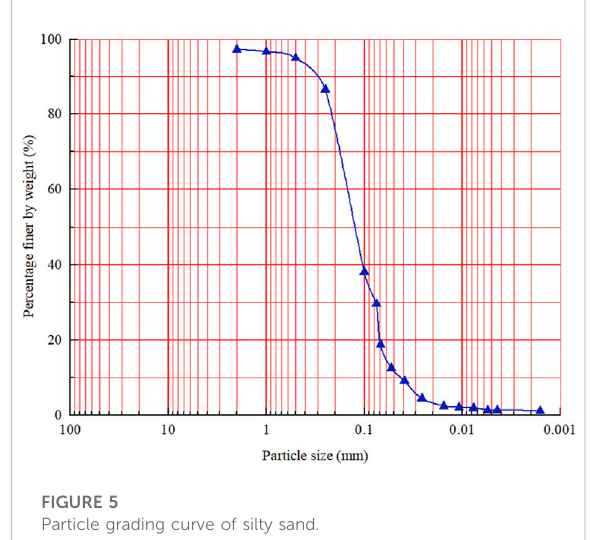
FIGURE 5 Particle grading curve of silty